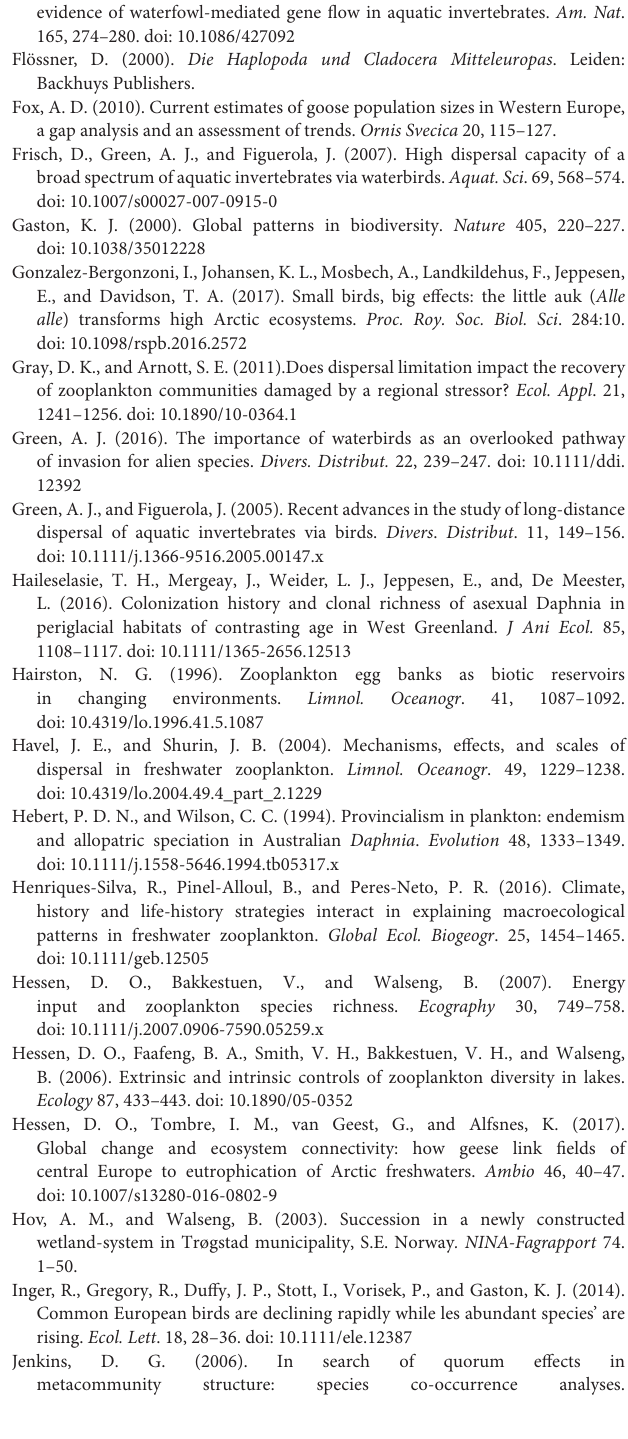
Figuerola, J.,Green, A. J., and Michot, T. C. (2005). Invertebrate eggs can fly: evidence of waterfowl-mediated gene flow in aquatic invertebrates. Am. Nat